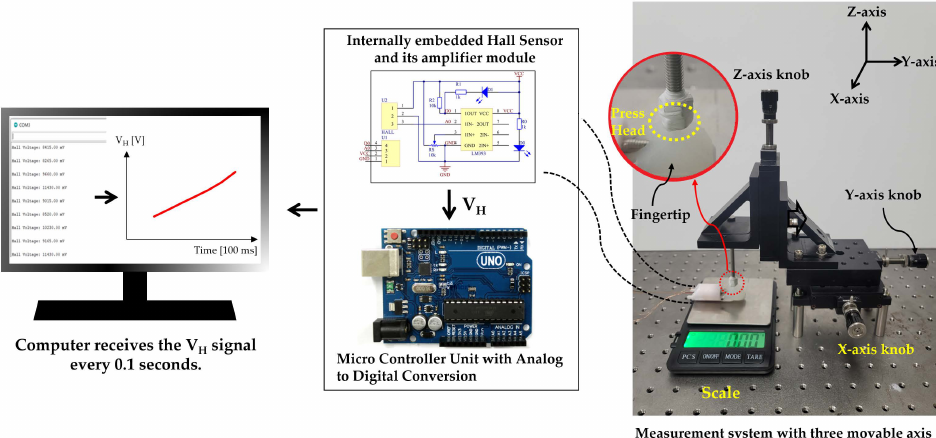
Figure 5. Measurement setup of the OFP sensor using the three-axis moving stage, where the press head contact area with the fingertip surface is 10 2 mm 2